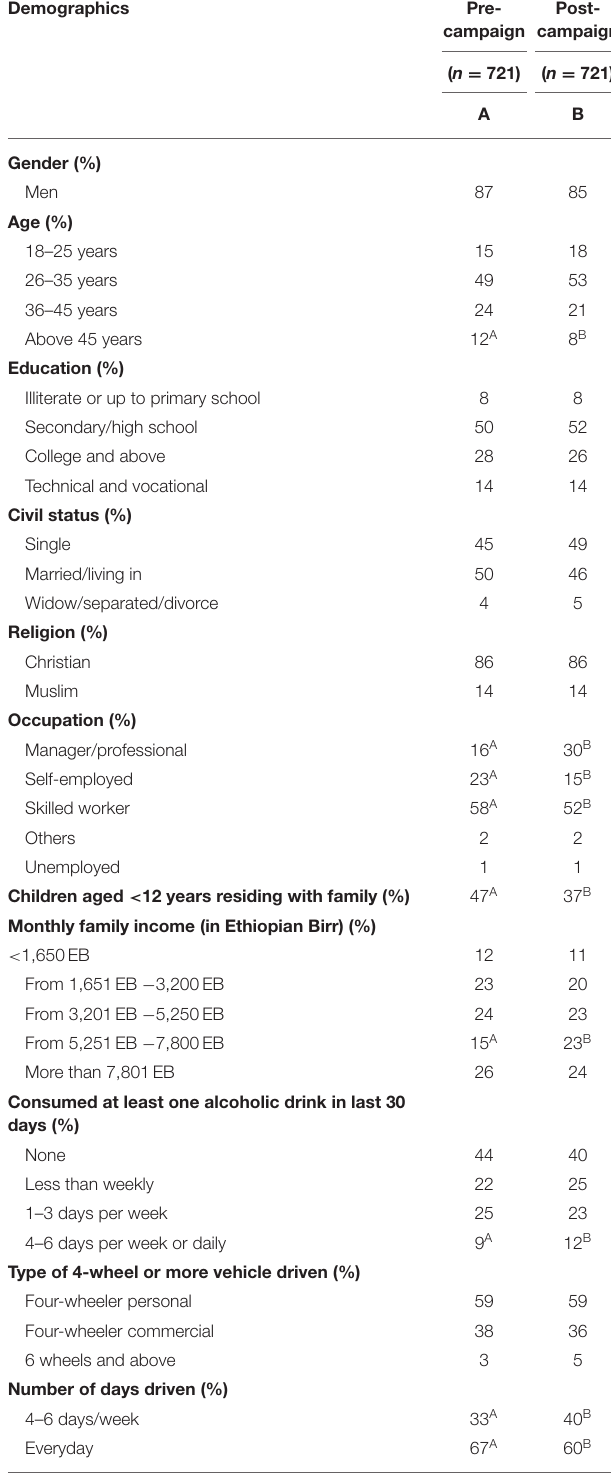
TABLE 1 | Demographic characteristics of participants in pre- and post-campaign